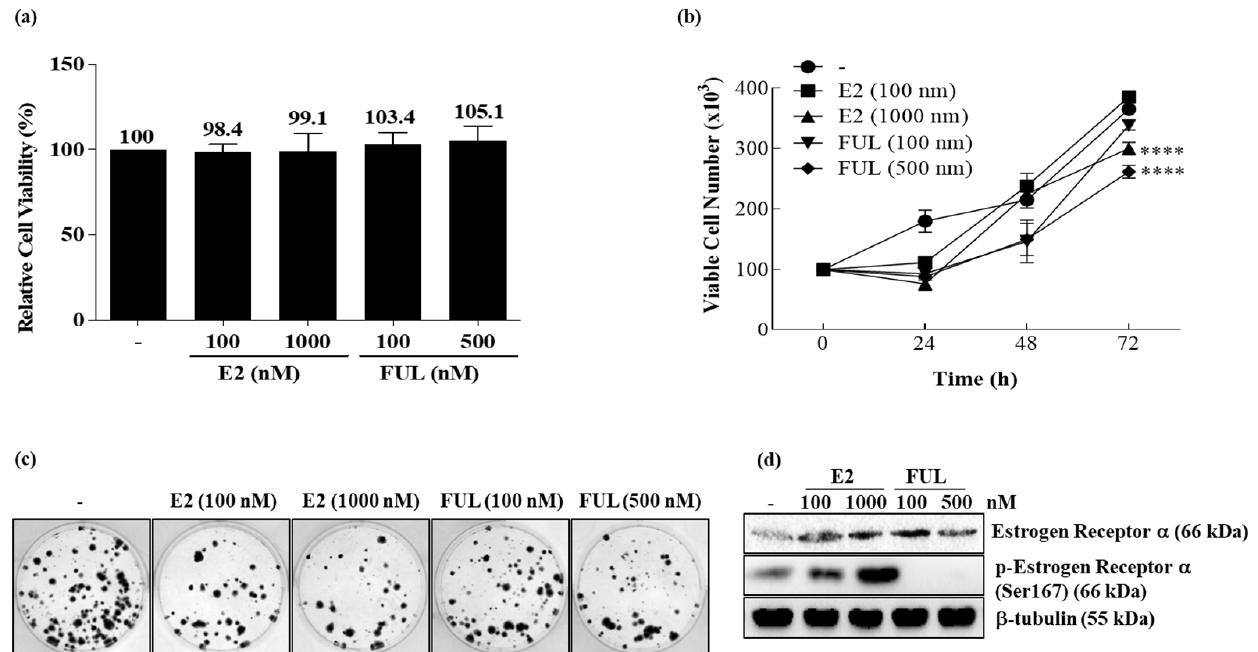
Figure 1. Determining appropriate concentrations of 17- β -Estradiol (E2)or Fulvestrant (FUL) treatment in MCF-7 breast cancer cells. ( a ) MTT cell viability assay proceeded to evaluate cytotoxic responses against two different concentrations of each drug. Columns represent the mean ± Std.dev of three independent experiments with at least four repeats. The analysis was performed by one-way ANOVA, Tukey’s multiple comparison test. ( b ) Viable cell numbers of MCF-7 cells treated with 100 nM and 1000 nM 17- β -Estradiol (E2), and 100 nM and 500 nM Fulvestrant (FUL) (**** p < 0.0001 by two-way ANOVA, Tukey’s multiple comparison test). ( c ) Representative image of colony formation assay to compare untreated control samples to 17- β -Estradiol (E2) (100–1000 nM) or Fulvestrant (FUL) (100–500 nM); ( d ) confirmation assay to evaluate E2 and FUL treatment by immunoblotting of dose-dependent E2 or FUL treated MCF-7 cell lysates. β -tubulin was used as a loading control. The relative densitometry analysis was performed by two-way ANOVA Tukey’s multiple comparison test (**** p < 0.0001, uncropped Western Blot Figures are shown in supplementary ma- terials).